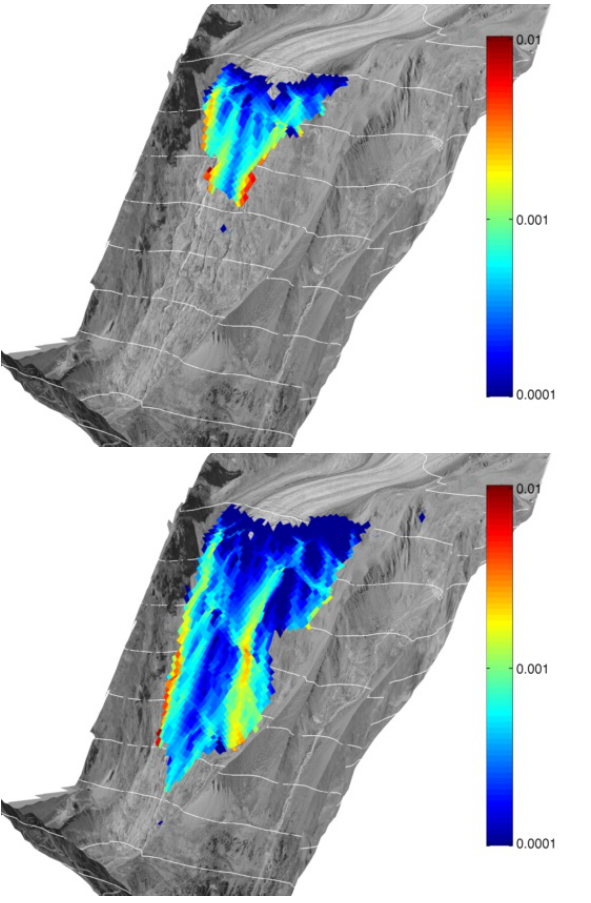
Fig. 8. Relative contribution of each block to the total subglacial water discharge (Z ev ) for 1999 (a) and 1982 (b) . Red zones indicate where discharge of subglacial water is larger.